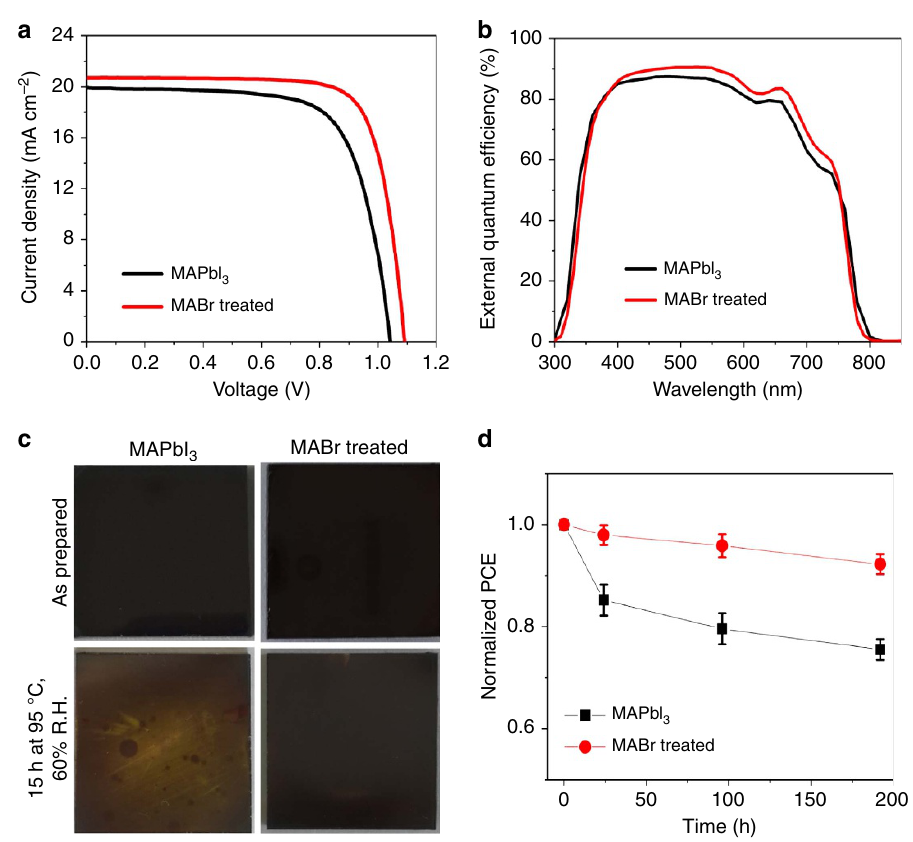
Figure 2 | Device characteristics and stability comparison. Comparison of ( a ) J – V characteristics and ( b ) EQE spectra for planar perovskite solar cells based on MAPbI 3 thin films with and without MABr treatment. ( c ) Comparison of the photographs of as-prepared MAPbI 3 thin films (with and without MABr treatment) versus those subjected to 15h exposure to 60% relative humidity (R.H.) at 95 (cid:2) C. ( d ) Device stability comparison of perovskite solar cells based on MAPbI 3 thin films with and without the MABr treatment. The error bars represent the s.d.’s from eight devices.